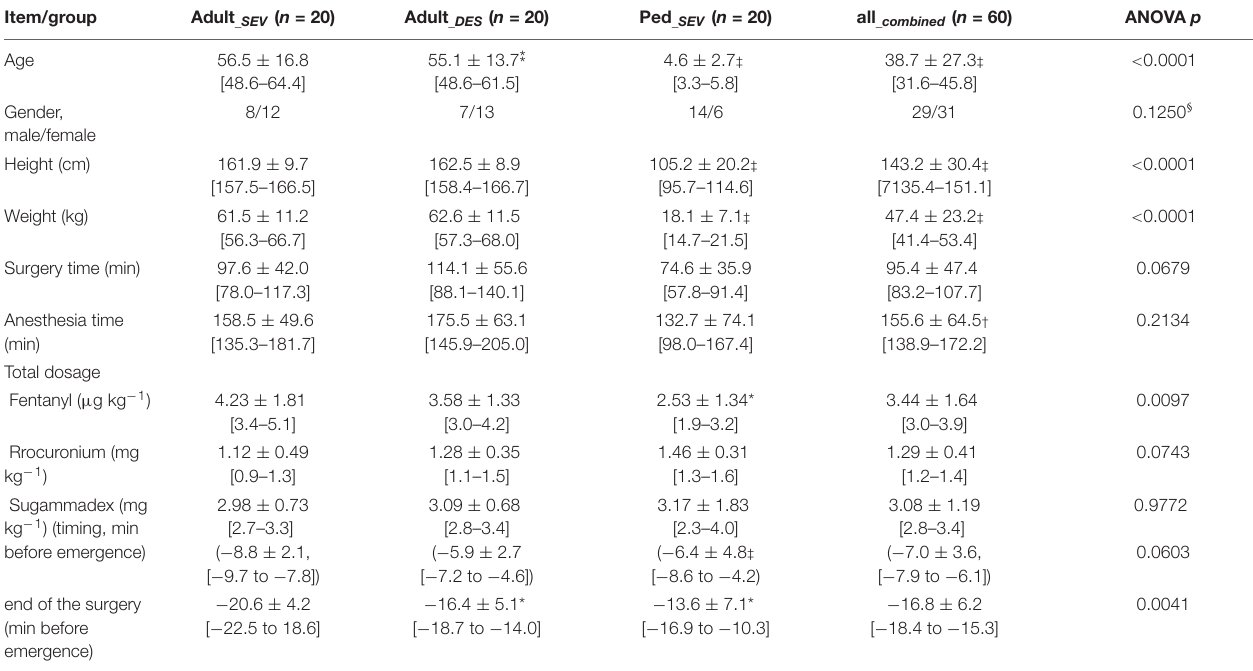
TABLE 1 | Patient characteristics and anesthesia management